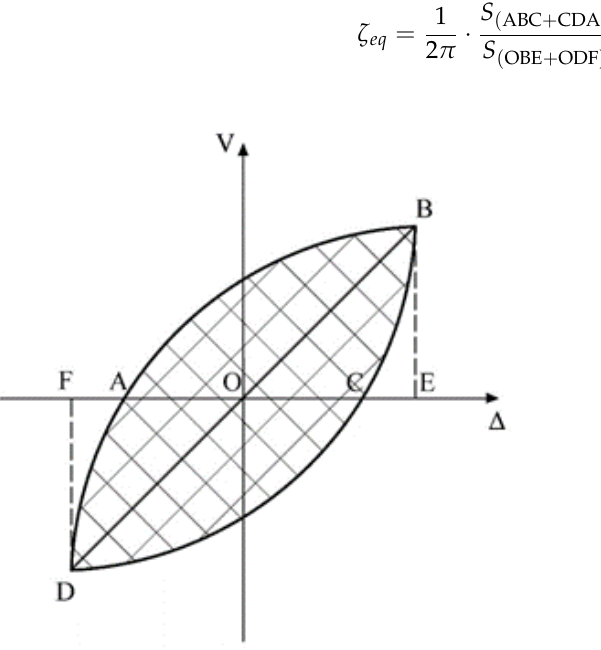
Energy dissipation performance reflects the energy consumption capacity of compo- nents under earthquake action. Usually, the fuller the hysteretic curve is, the stronger the energy dissipation performance, and the better the seismic performance. Under repeated loading, the member absorbs external energy during loading and releases energy during unloading. The subtraction of the energy during the cycle is defined as energy dissipation, as shown in Figure 14, which is equal to the area surrounded by the hysteresis loop. The equivalent viscous damping coefficient, ξ eq calculate with Equation (4), and the cumulative energy dissipation, Σ S , can be used to evaluate the energy dissipation capacity of members in an earthquake.